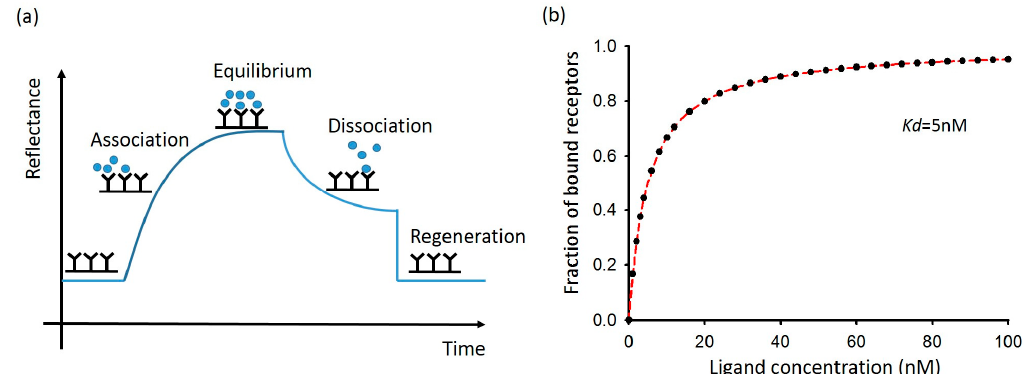
Figure 2. The kinetic and equilibrium state of a receptor and ligand binding event measured by an SPR sensor. ( a ) Reflectance of an SPR sensor when a binding event occurs, attains equilibrium, dissociates, and eventually returns to the original state; ( b ) The equilibrium of binding at various ligand concentrations determined by an SPR sensor.